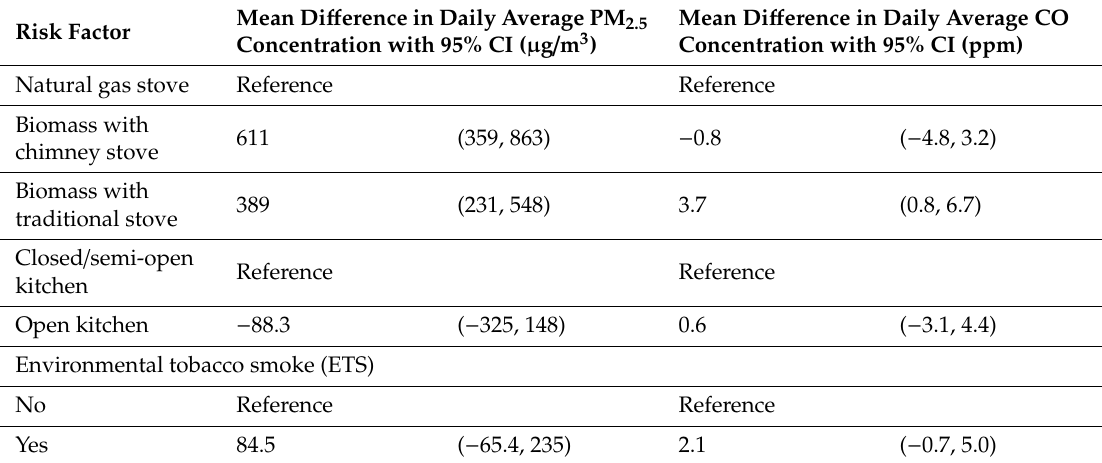
Table 3. Mutually adjusted multivariate linear regression coe ffi cients for factors that might influence PM 2.5 and CO concentrations in kitchens. Analysis is based on 35 households for PM 2.5 and 34 for CO. Mean Di ff erence in Daily Average PM 2.5 Mean Di ff erence in Daily Average Risk Factor Concentration with 95% CI ( µ g / m 3 )